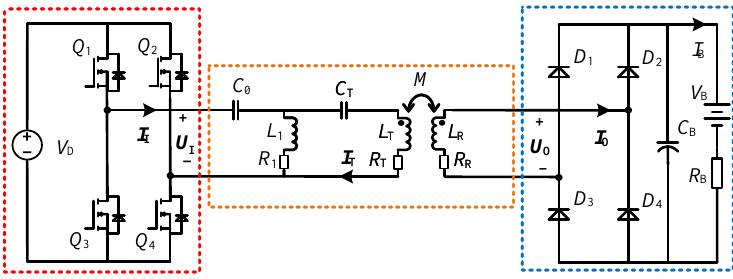
Figure 1. Architecture diagram of the CLC/N compensated WPT